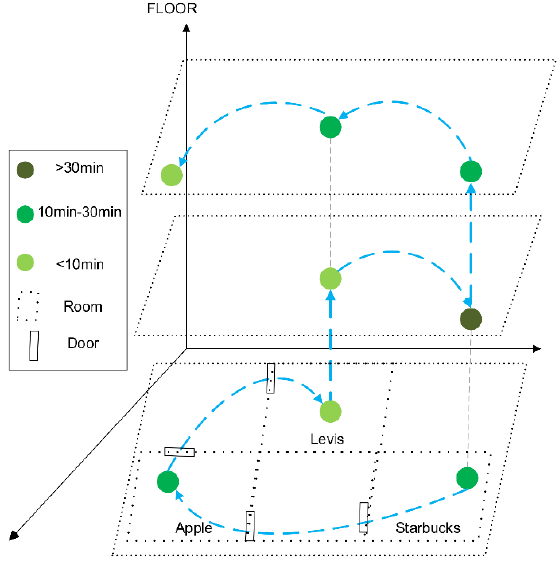
Figure 13. Semantic trajectory. The circle represents the moving object.